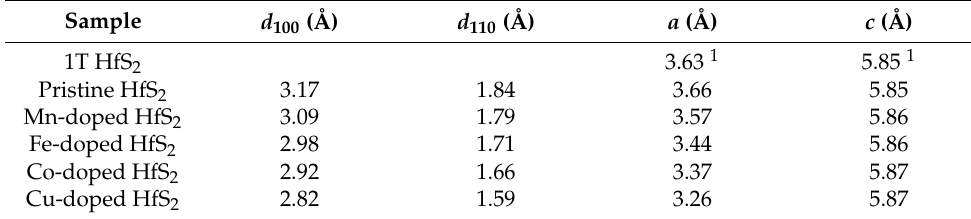
Table 2. Lattice parameters of the pristine, Mn-, Fe-, Co-, and Cu-doped HfS 2 crystals.